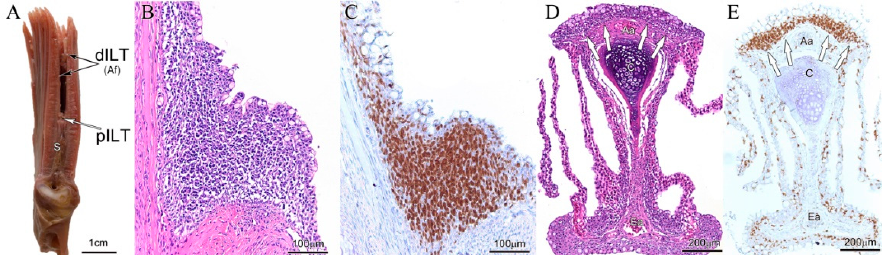
Figure 3. Gill-associated lymphoid tissue (GIALT) or interbranchial lymphoid tissue (ILT) of Atlantic salmon ( Salmo salar ). All images were taken from the second left gill arch. ( A ) Macroscopic image of a transversally dissected gill. The white arrow points to the proximal part of the ILT (pILT) as seen in image ( B , C ). Black arrows point to the distal part of the ILT (dILT) as seen in image ( D , E ). The interbranchial septum S forms the bottom of the interbranchial cleft. ( B ) Hematoxylin/Eosin (H&E) staining of the ILT showing intraepithelial lymphoid aggregates. ( C ) Zap-70 staining of the corresponding region showing high numbers of Zap-70+ cells (brown). ( D ) H&E staining of a filament (sectioned in the coronary plane with regards to the filament cartilage). White arrows point to the dILT. ( E ) Zap-70 staining of the corresponding region showing high numbers of Zap-70+ cells within the epithelium of the afferent aspect of the filament (i.e., dILT).